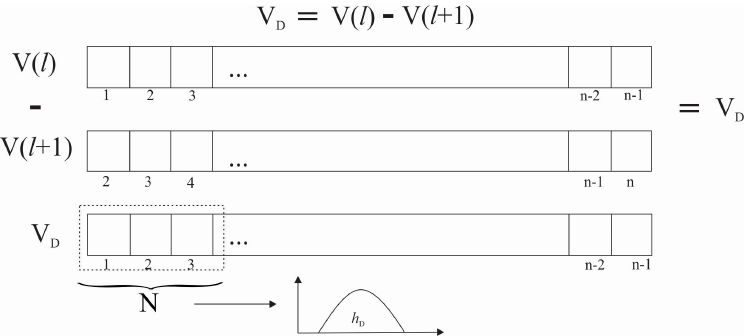
Figure 4. General process of the sum and difference of histograms (SDH) method in a